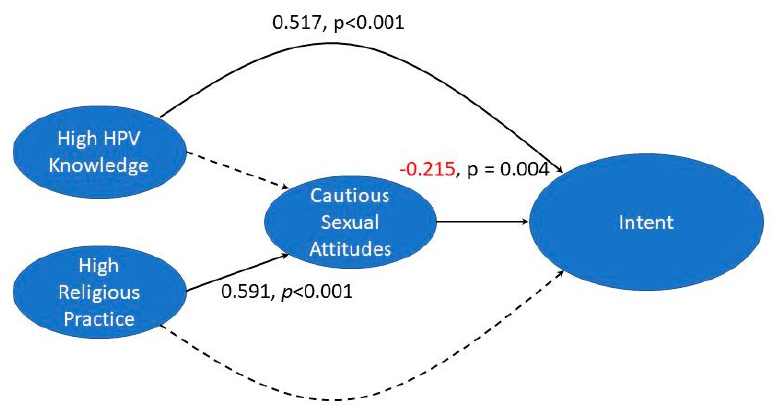
Figure 5. Cautious sexual attitudes negatively impact intent to vaccinate for HPV. The latent